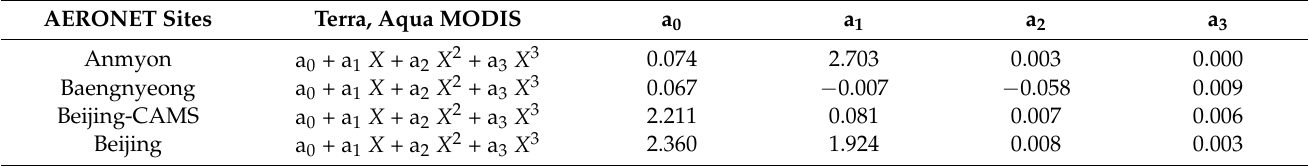
Table A3. Summary coefficients of Terra, Aqua/MODIS AOD products during 2016 in training data ( X = AOD ). AERONET